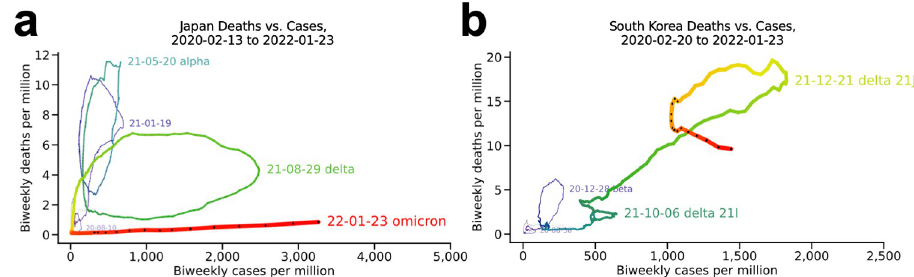
Fig 4. Japan and South Korea. (a) Japan and (b) South